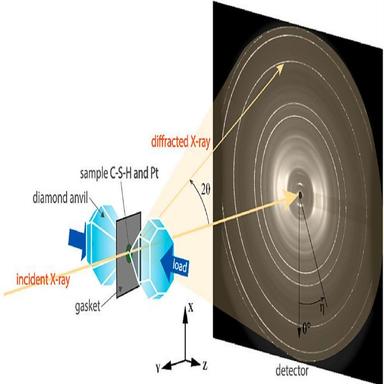
Schematic representation of the DAC radial diffraction geometry. The Y-axis is aligned with the incident beam path, and the Z-axis is aligned with the axis of a diamond anvil cell.